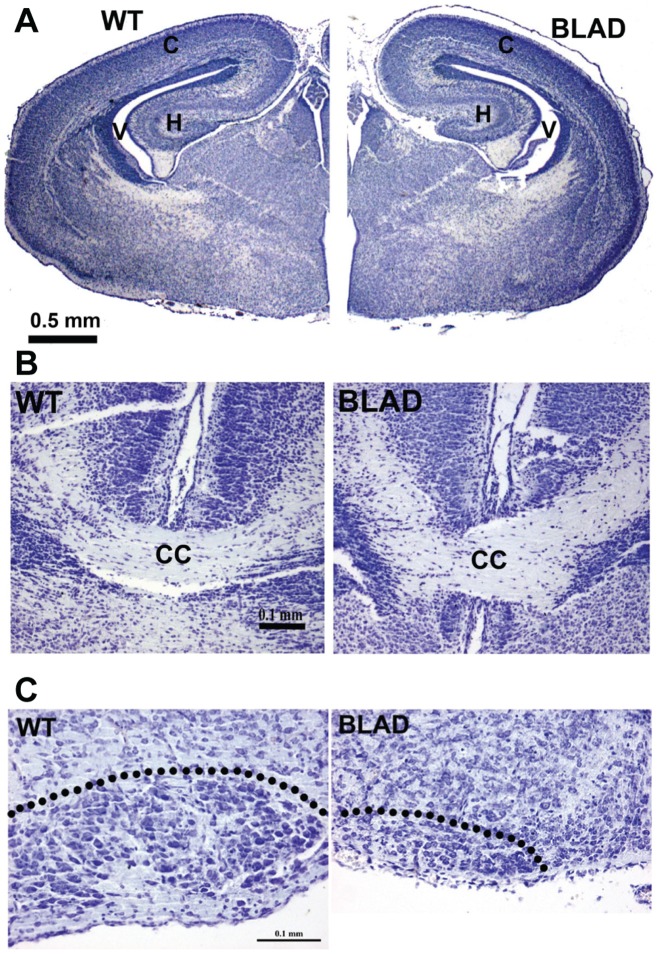
Brain and facial motor nucleus morphology.Transverse sections of E18.5 WT (left) and Nmnat2blad/blad (BLAD) (right) forebrains (A), and higher magnification views of the corpus callosum (B). Up is dorsal in (B). (C) Transverse sections of E18.5 WT (left) and BLAD (right) brainstem showing the loss of facial motoneurons (see text for quantitation). Dotted line denotes the boundary of the motor nucleus. H, hippocampus; V, ventricle; C, cortex; CC, corpus callosum.